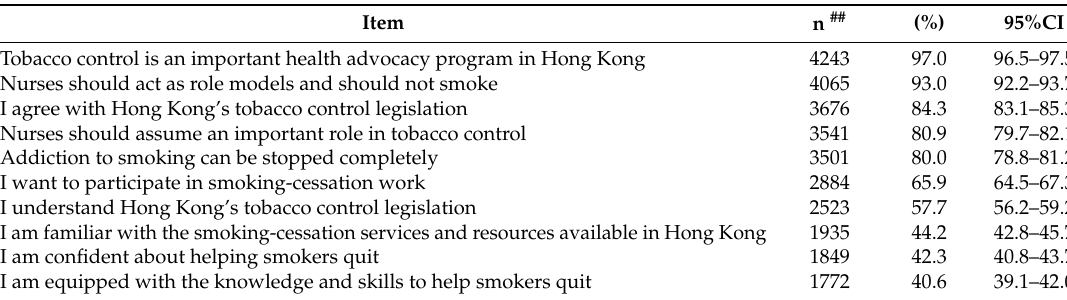
Table 5. Nurses’ attitudes (agree) towards smoking cessation (N = 4413) # .